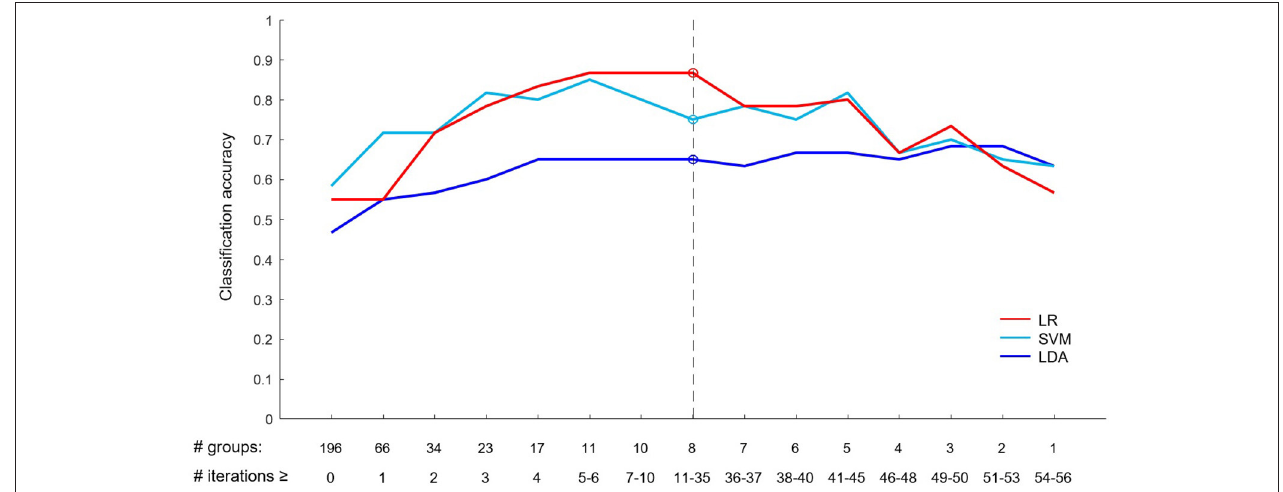
FIGURE 6 | Classification accuracy based on a number of selected groups of electrodes. The bottom row of numbers shows a minimum number of LOO iterations (# iterations) in which a given number of electrode groups (# groups) were selected as most discriminative (e.g., eight electrode groups were selected as maximally discriminative in 35 or more LOO iterations). The best LR classification accuracy and corresponding results for SMV and LDA (shown in Table 2 ) are depicted by circles and a dashed